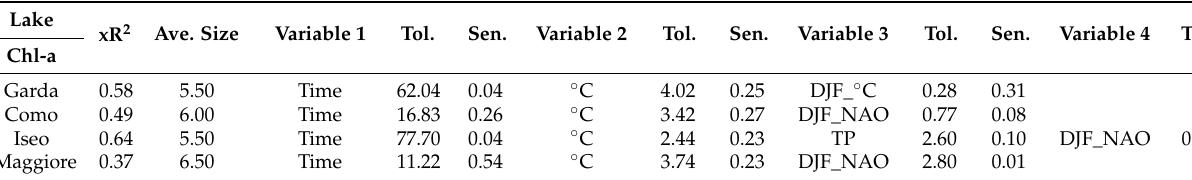
Table 2. Results of NPMR (Non-Parametric Multiplicative Regression) models for Chlorophyll-a (2003–2018). xR 2 = cross-validated R 2 ; Ave. size = Average neighbourhood size; Tol. = Tolerance; Sen. = Sensitivity. DJF_°C = December, January February mean temperature; DJF_NAO = December, January February mean North Atlantic Oscillation values; TP = Total Phosphorus.